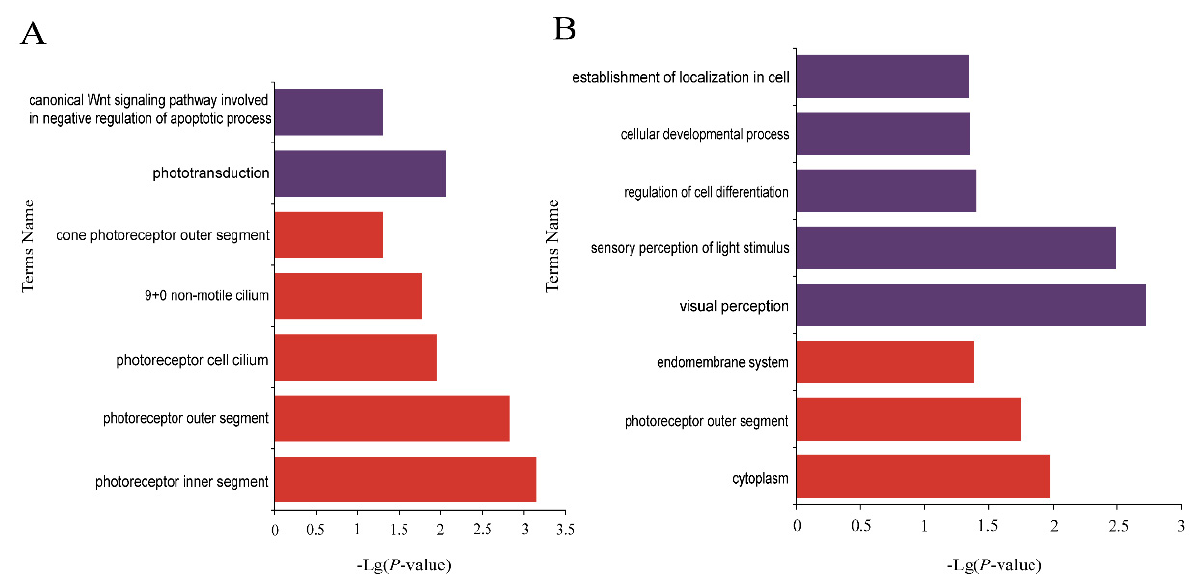
Figure 7. The functional enrichment analysis of specific genes expressed in the hypothalamus of Small Tail Han Sheep. ( A ) Enriched GO terms of luteal phase, ( B ) Enriched GO terms of estrus. Different bar chart colors represent different items. Purple represents BP, red represents CC, and blue indicated MF.